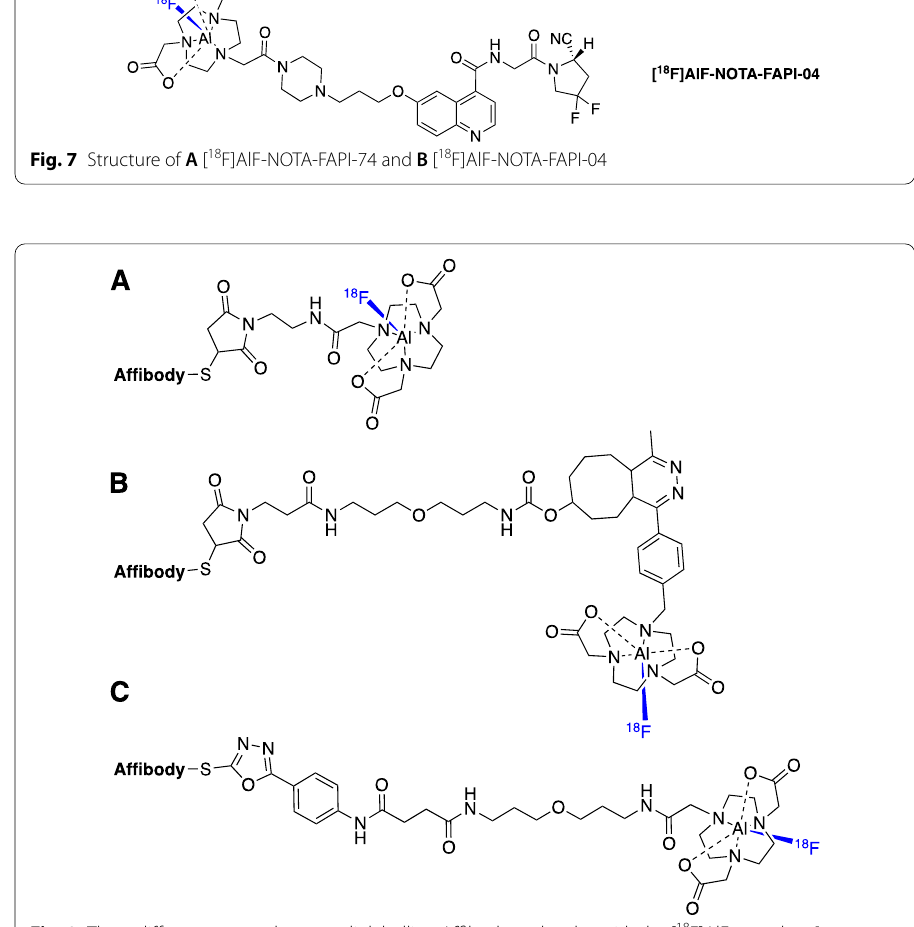
Fig. 8 Three different approaches to radiolabelling Affibody molecules with the [ 18 F]AlF complex: A maleimide-thiol conjugation; B IEDDA “click” approach and C PODS